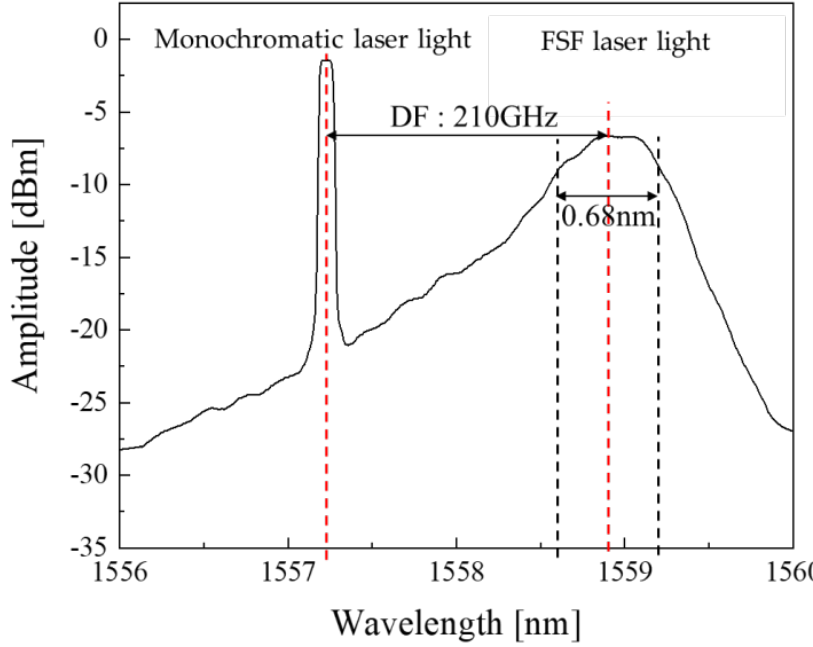
Figure 3. Pump light spectrum for generating frequency-shifted terahertz (FS-THz) waves.